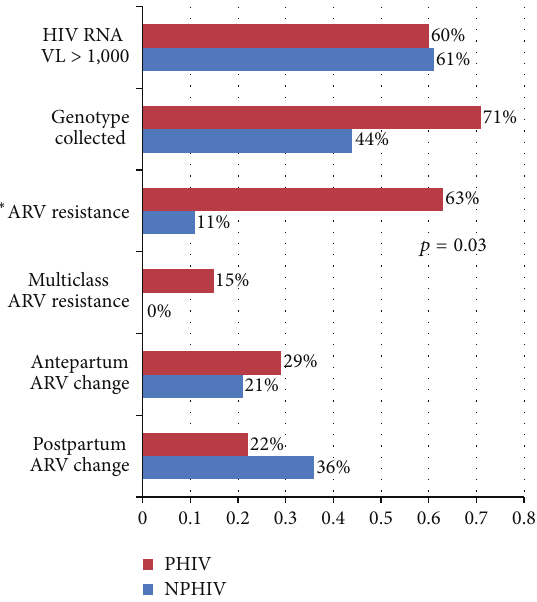
Figure 2: Antiretroviral drug resistance testing and therapy changes in women with perinatal and nonperinatal HIV infection. The proportion of women with a genotype collected and ARV resistance accounts for the number of participants eligible to have a genotype evaluated (HIV RNA viral load > 1,000 copies/mL). ∗ ARV resistance and multidrug resistance rates were significantly different between